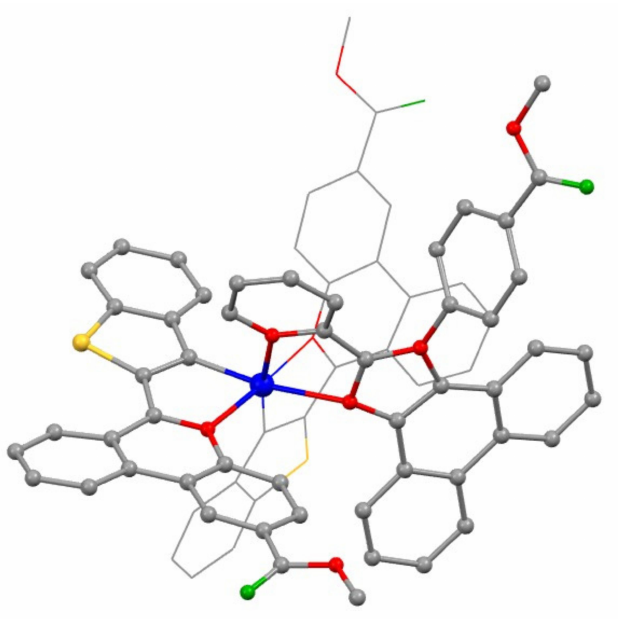
Figure 2. Optimized structure of the model Ir0 complex (hydrogen atoms are omitted for clarity). The calculations have been slightly simplified by substitution of OEG pendants with methyl groups. Atom colors: Ir–blue; N–red; S–yellow; O–green;